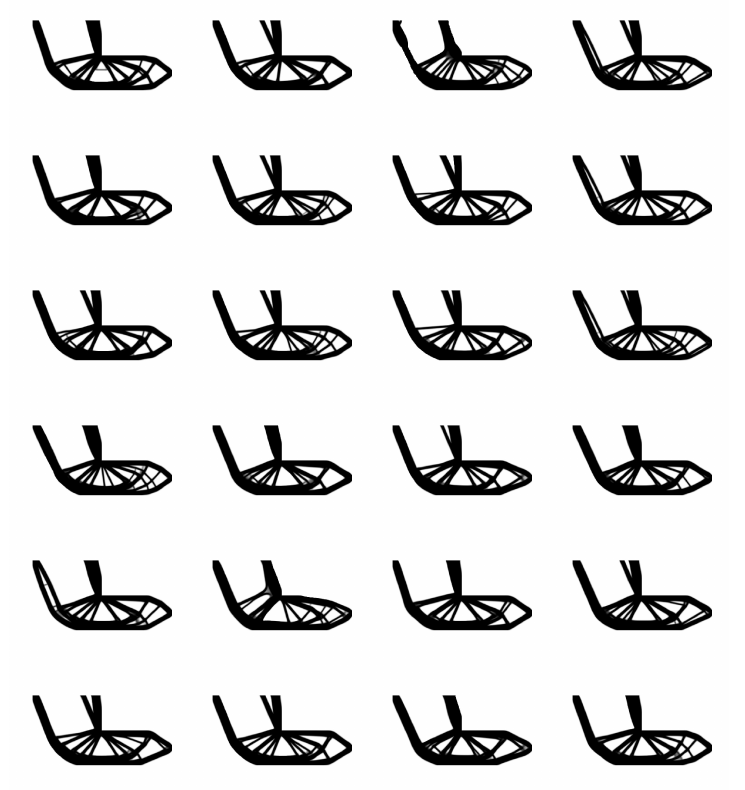
Figure 8. Results for test example